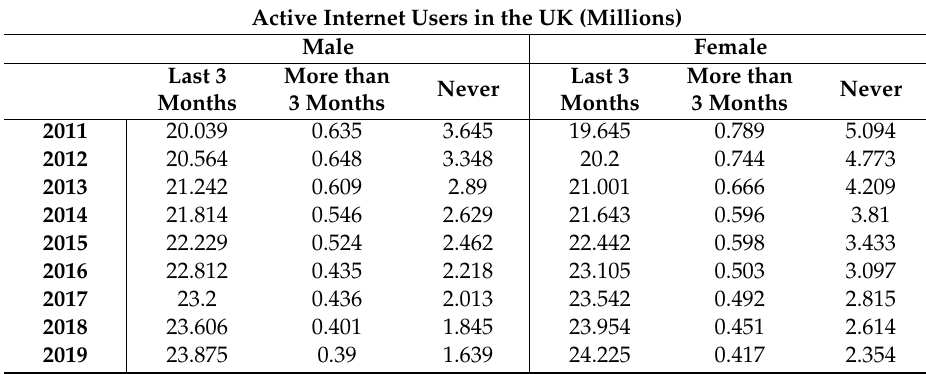
Table 1. Male and female internet users in the United Kingdom, O ffi ce for National Statistics (2019a). Active Internet Users in the UK (Millions) Male Female Last 3 More than Last 3 More than Never Months 3 Months Months 3 Months